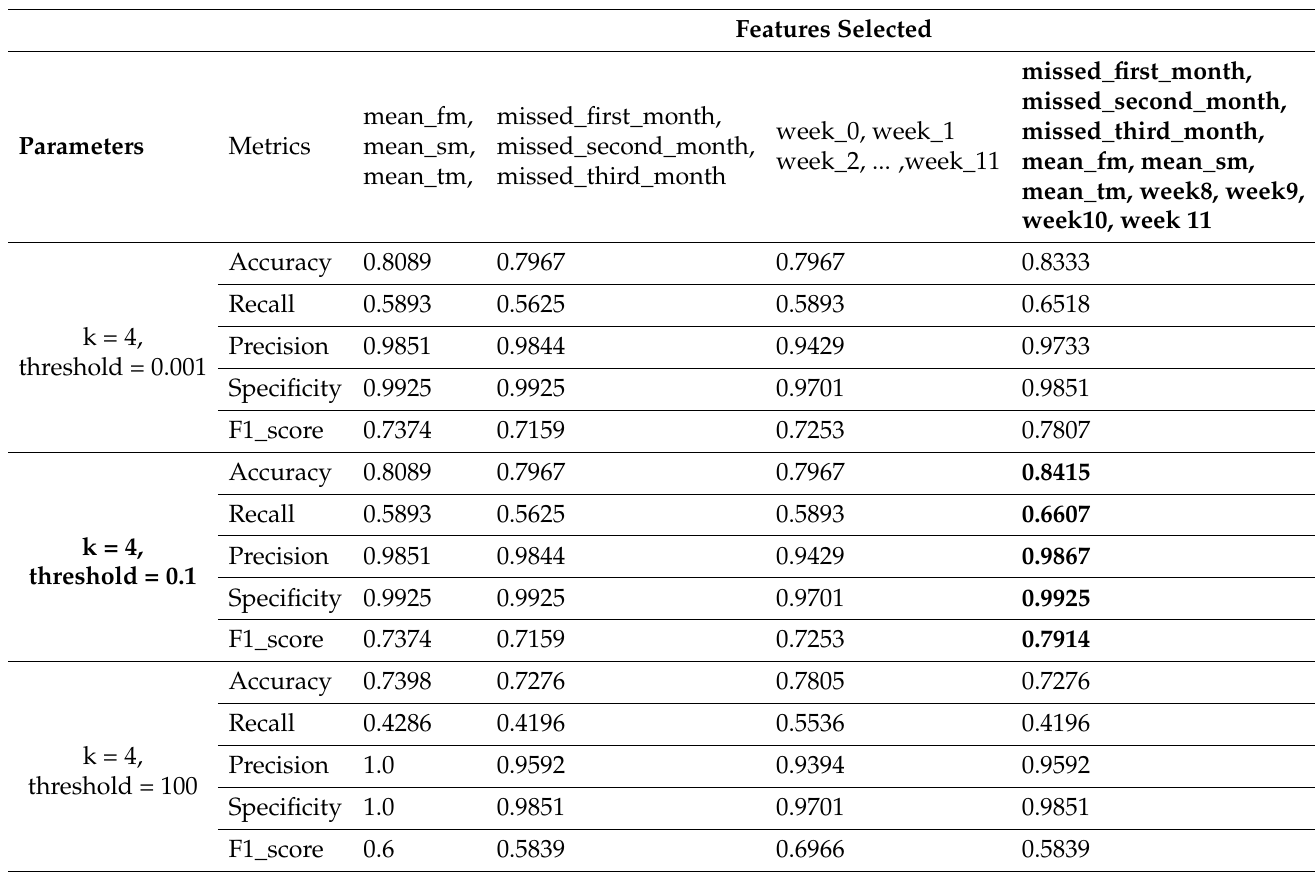
Table 18. Metrics, applying different configurations for BIRCH clustering—LSTM. Features Selected